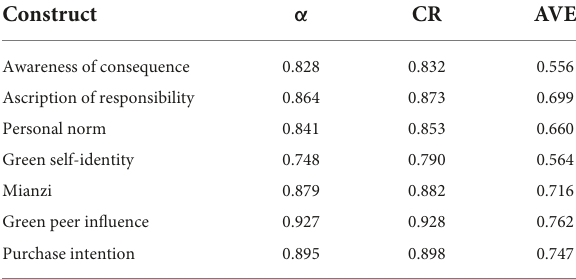
TABLE 2 Results of measurement model